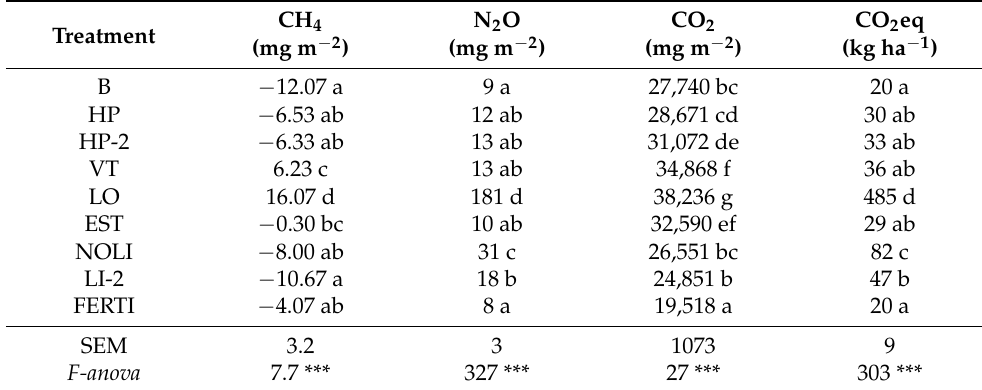
Table 4. Estimated cumulative fluxes during the 55-day measuring period.